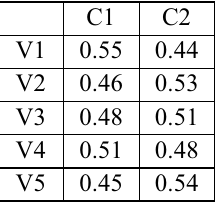
Table: 5 shows that the QoS membership of the nodes